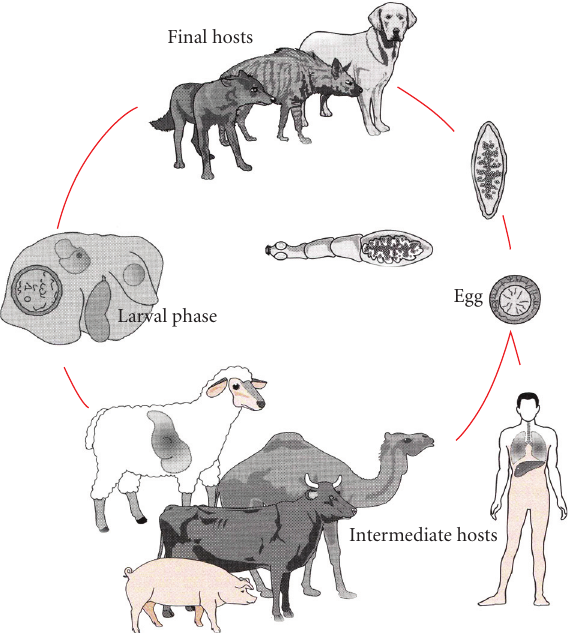
Figure 1: Vital cycle of E. granulosus .